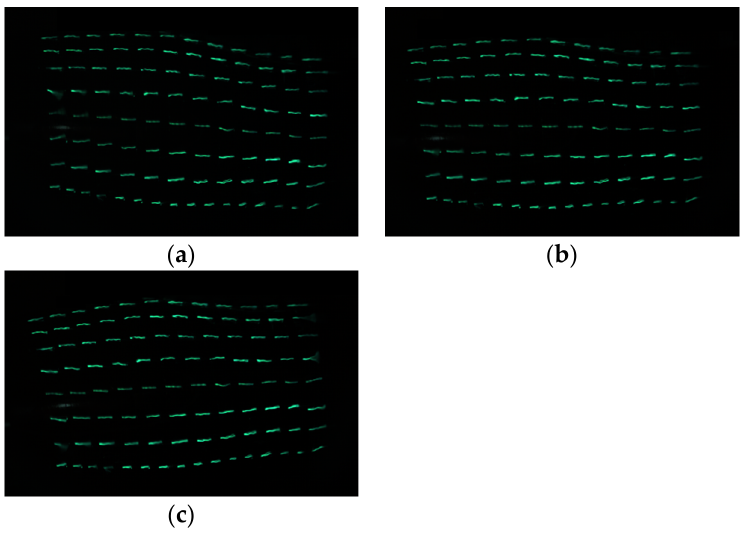
Figure 3. Snapshot example. ( a ) θ a = 4°; ( b ) θ a = 0°; ( c ) θ a = − 4°.